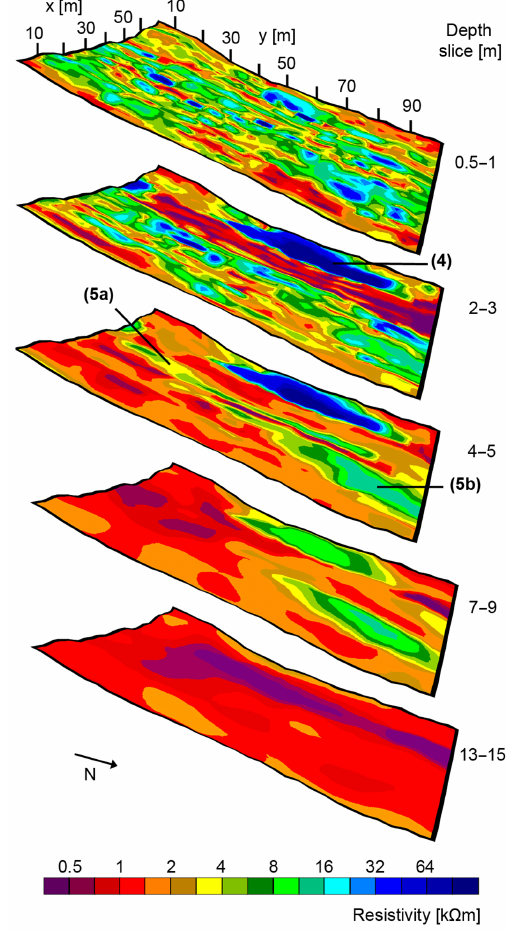
Figure 7. Selected depth slices of the quasi-3-D ERI model for Uertsch_02. Numbers refer to structures described in the